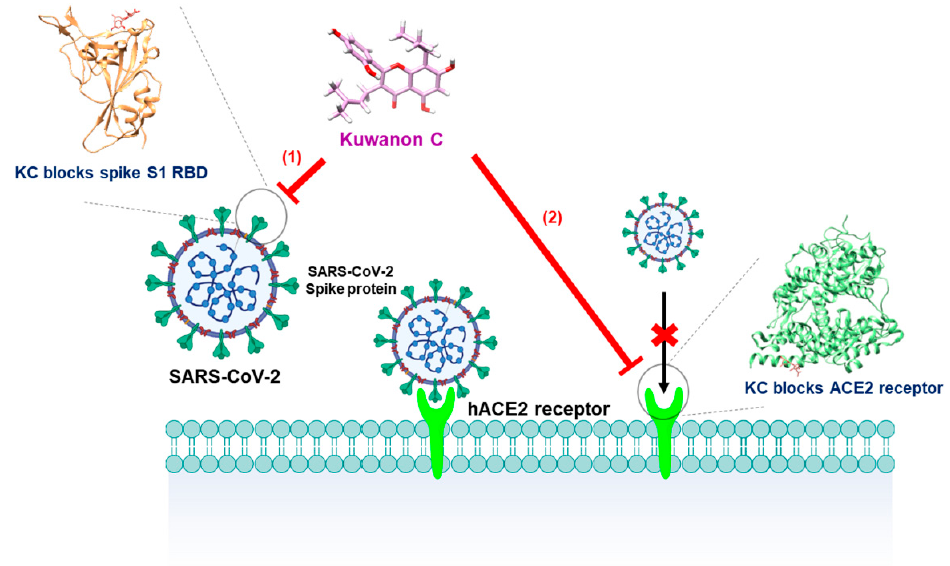
Figure 6. Schematic of the blockade of the SARS-CoV-2 spike S1 RBD:ACE2 receptor interaction by KC.